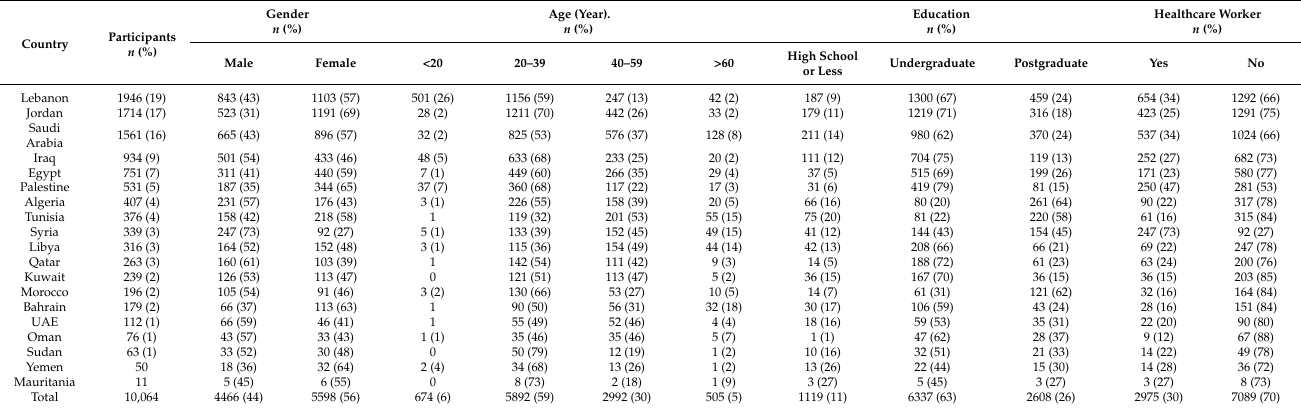
Table 2. List of surveyed countries and demographic characteristics of the